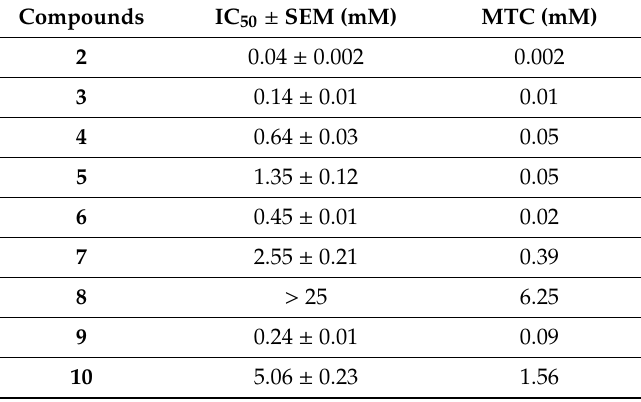
Table 3. Inhibitory concentration (IC 50 ) and maximum tolerated concentration (MTC) in A549